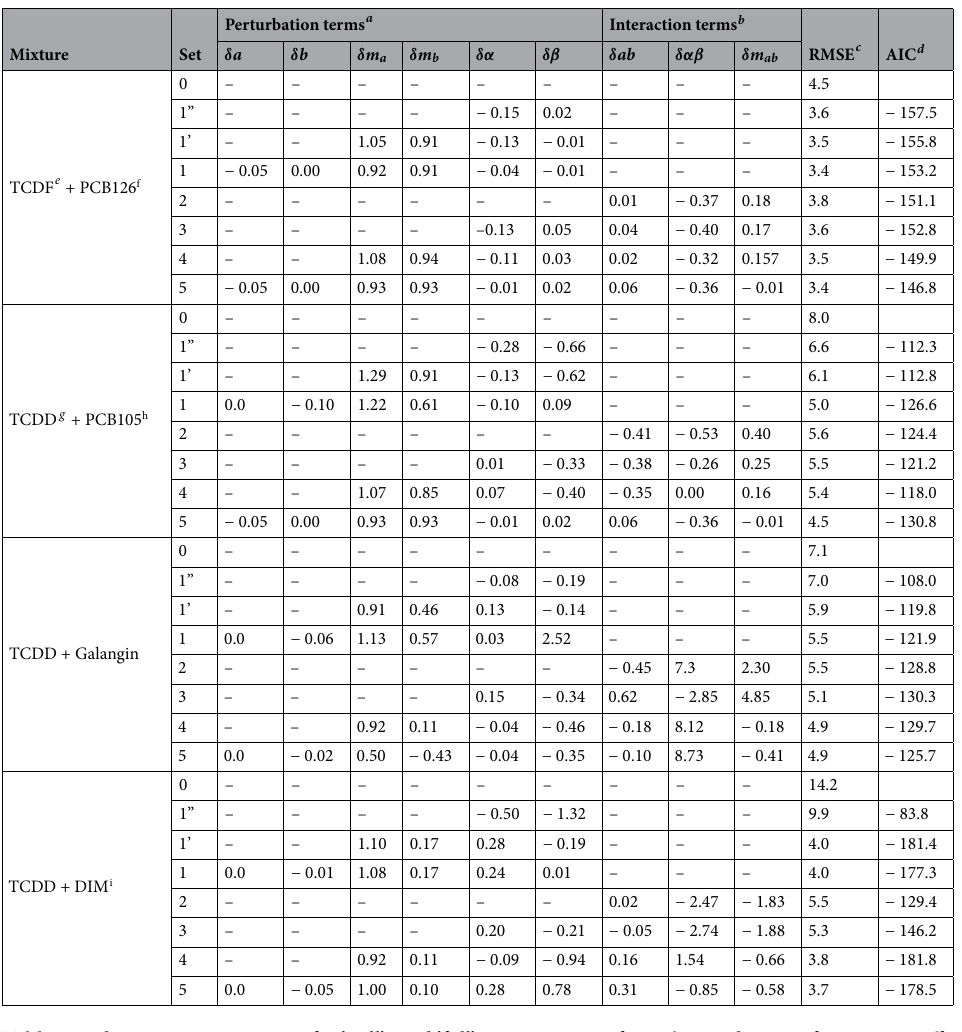
Table 4. AhR agonist parameters for ’null’- and ’full’-interaction surfaces. a Perturbation of maximum effects δ a , δ b , inflection points δ m a , δ m b and slopes δα , δβ , δ m a = e δ x 50 = 1 in Eq. (19) corresponds to δ x 50 = 0 , the same holds true for δ m b . b Interaction between maximum effects δ ab , slopes δαβ and inflection points δ m ab . c-d See legends g − h of Table 1. e-i See legends b − e of Table 3.